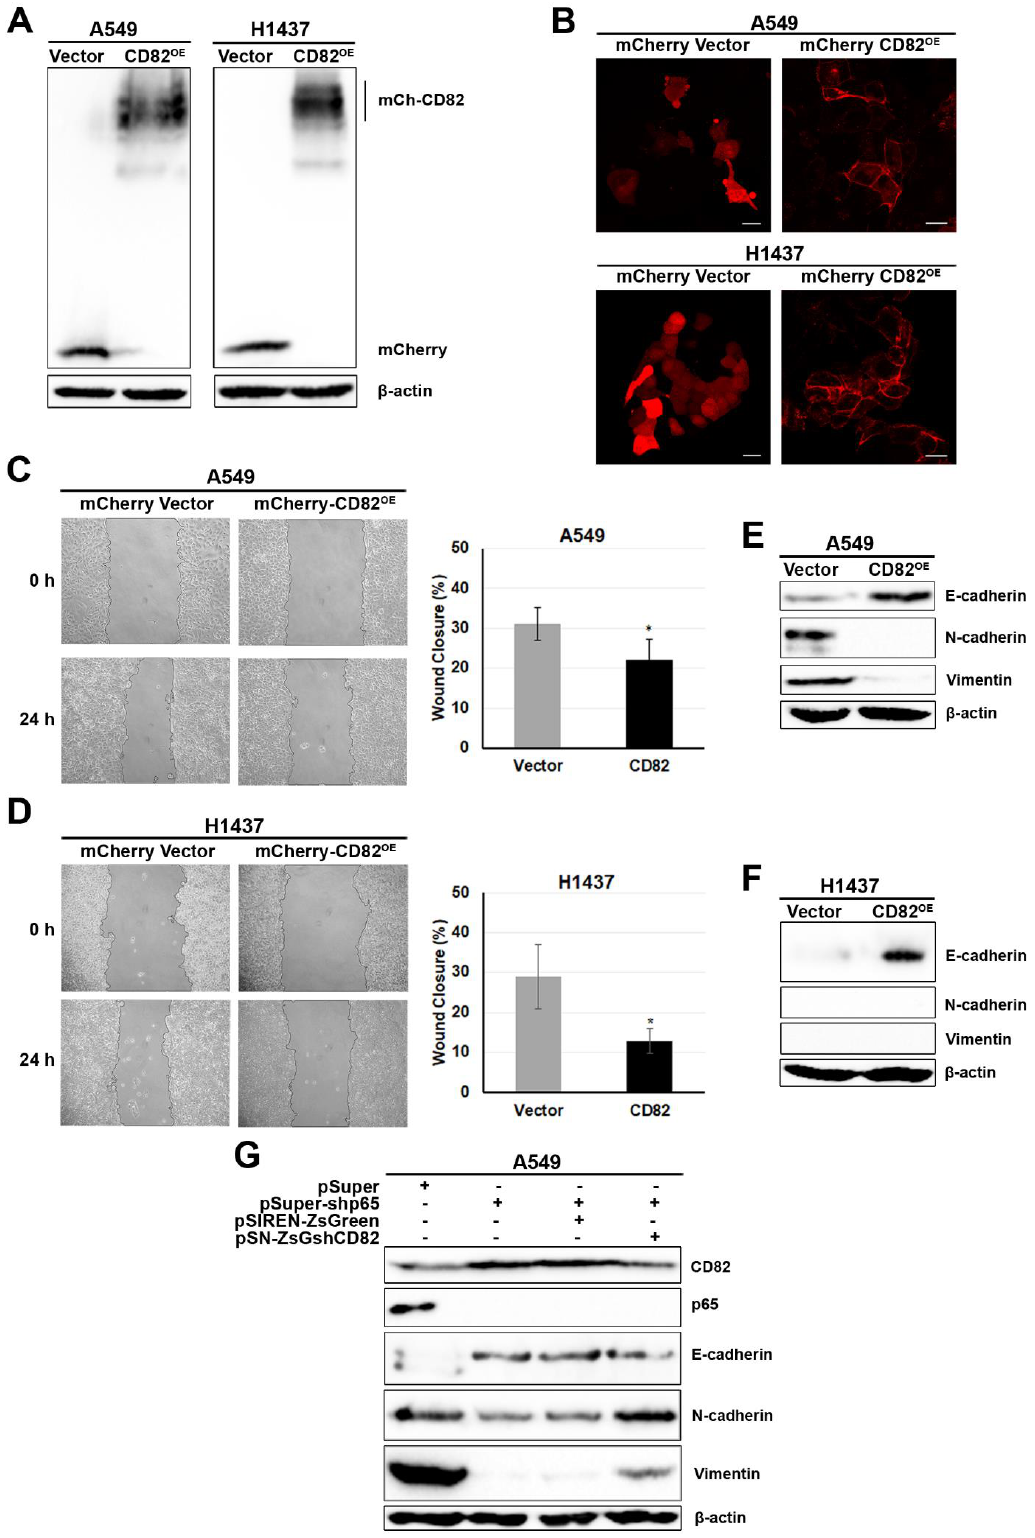
Figure 6. Effects of p65 and CD82 on cell migration and the expression of EMT markers in human lung cancer cells. ( A ) Gen- eration of CD82-overexpressing human lung cancer cells. Control mCherry and mCherry-CD82 OE (mCh-CD82 OE ) vectors were transfected in A549 and H1437 cells following selection in G418 to generate stable cell populations overexpressing the mCherry-CD82 fusion protein. ( B ) Cytoplasmic localisation of mCherry protein in vector control mCherry cells compared to membrane localisation in mCh-CD82 OE A549 and H1437 cells detected by fluorescence microscopy. ( C , D ) In